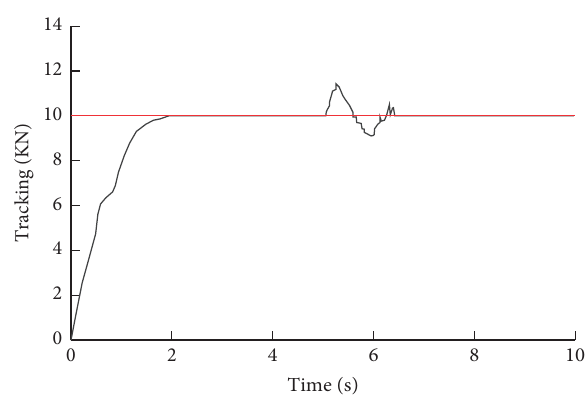
Figure 12: Constant force tracking with external